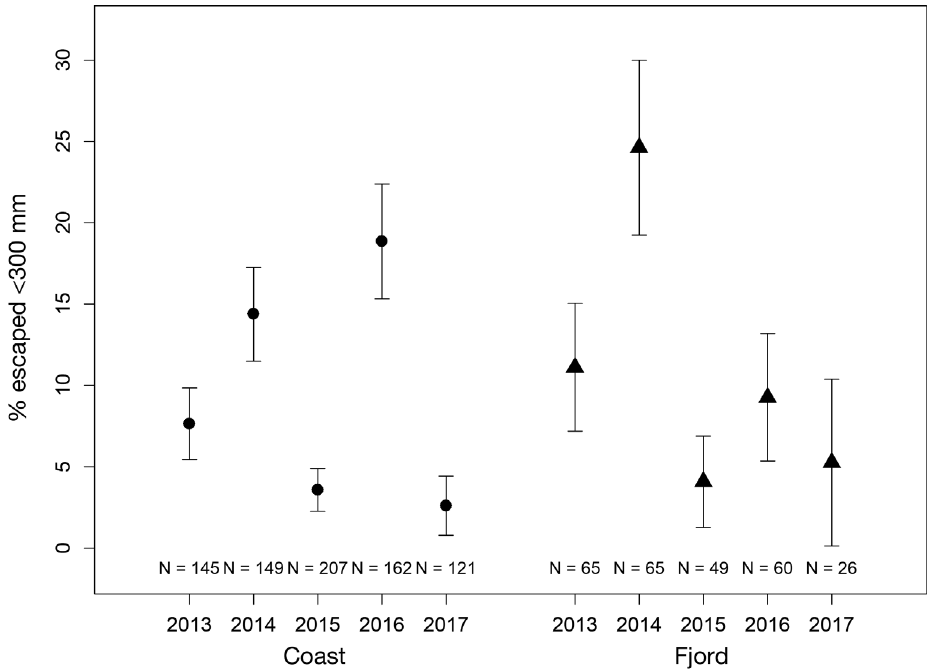
Fig. 4. Mean (±SE) proportion of individuals that escaped at a length of ≤300 (smolt/post-smolts) on the coast (circles) and in the fjord (triangles) from 2013 to 2017. The number of analyzed escapees is given on the graph for both locations